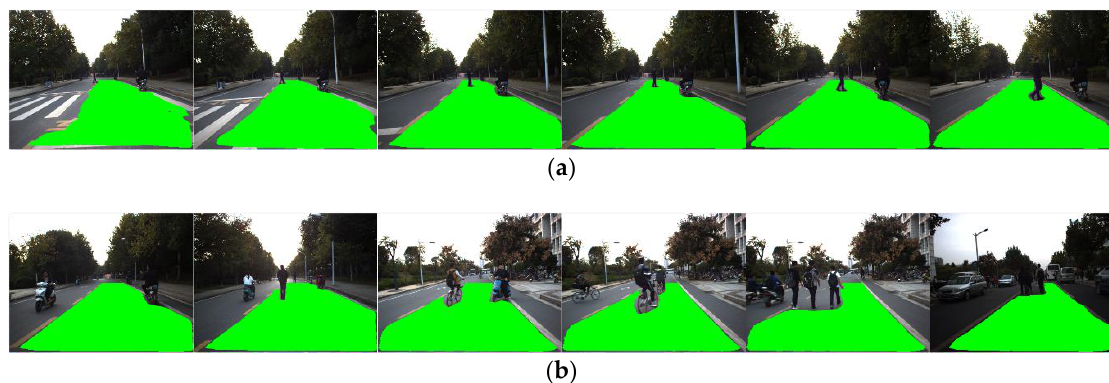
Figure 14. Detection results in the presence of: ( a ) Multiple road users; ( b ) various road users.